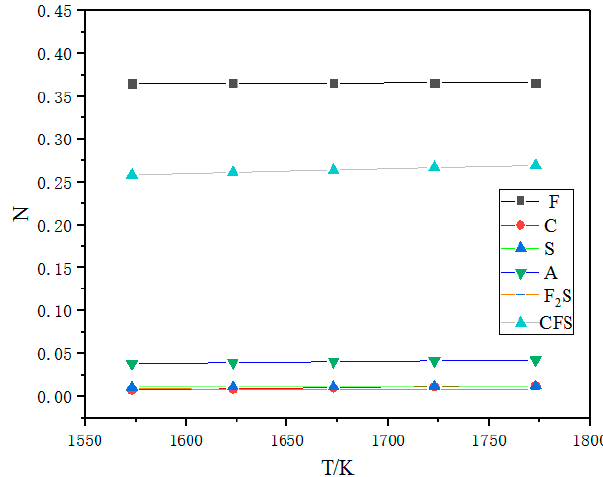
Figure 3. Activity of some components in slag 2 at different temperatures, F 2 S and CFS represent 2FeO · SiO 2 and CaO · FeO · SiO 2 , respectively.